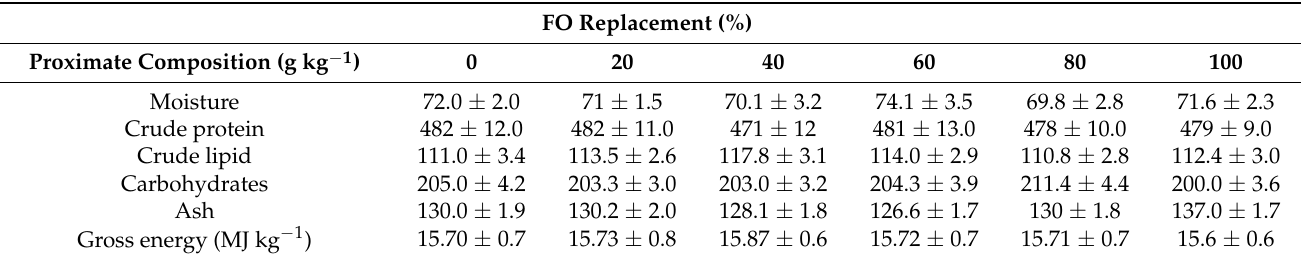
Table 2. Proximate composition (g kg − 1 diet, wet basis) of the experimental diets with different levels of replacement of cod liver oil (FO) by a blend of vegetable